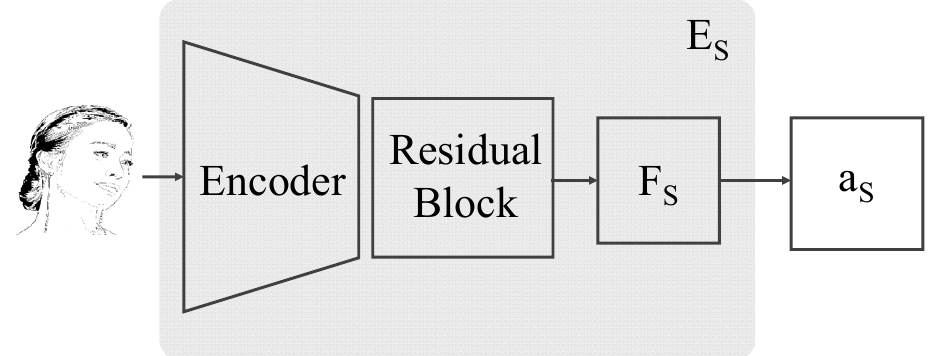
Figure 3. The structure of our style